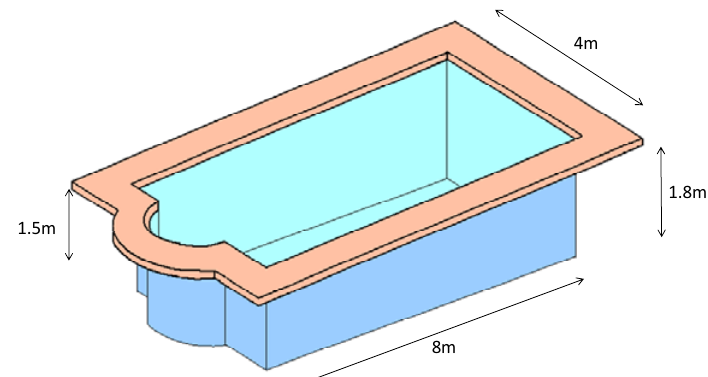
Figure 3. Swimming pool used to take